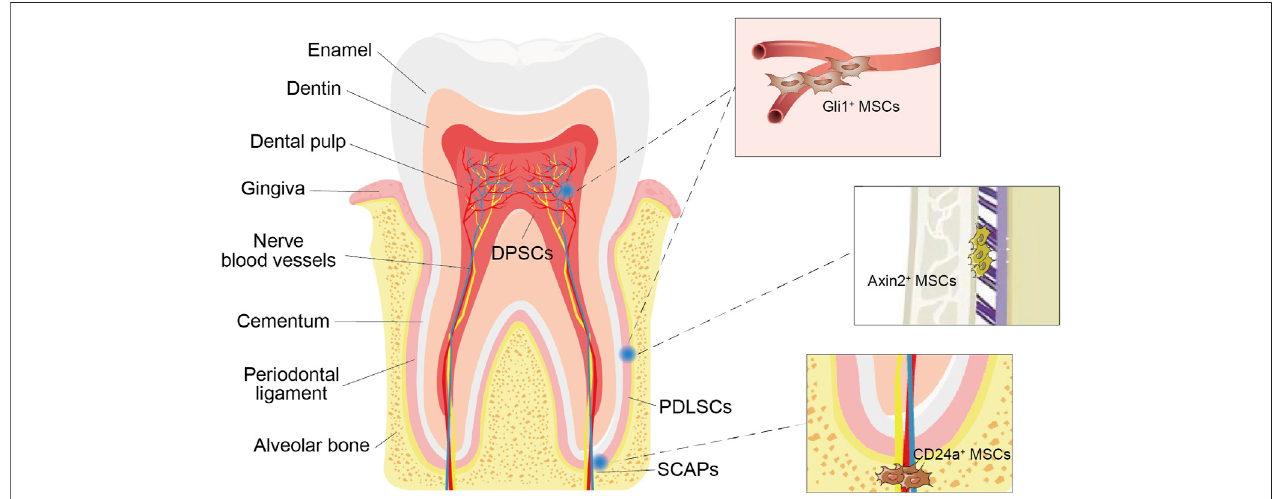
FIGURE 2 | Odontogenic MSCs and their subpopulations. Various types of stem cells, such as dental pulp stem cells (DPSCs), periodontal ligament stem cells (PDLSCs) and stem cells from the root apical papilla (SCAPs), can be found in the dental pulp and periodontal ligament around the tooth root. Gli1 + MSCs surround the vasculature exclusively. Axin2 + MSCs were identi fi ed in the periodontal ligament (PDL). CD24a + MSCs were present in human dental papilla tissues.